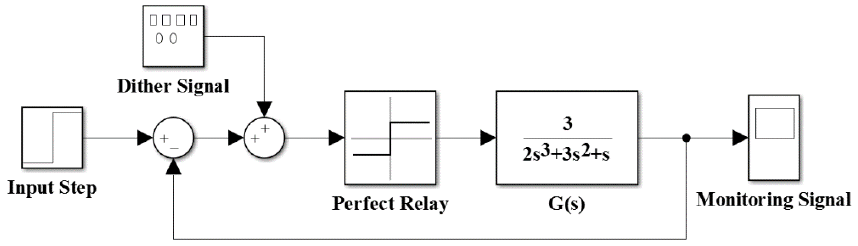
Figure 5. Simulink block diagram of the relay control system with dither injection.